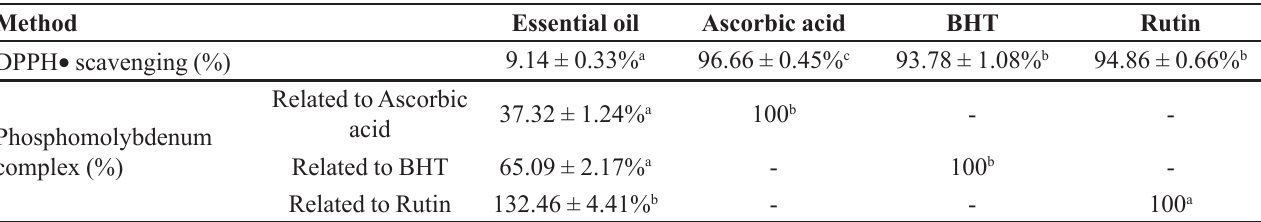
TABLE II - Antioxidant activity of Myrcia hatschbachii essential oil